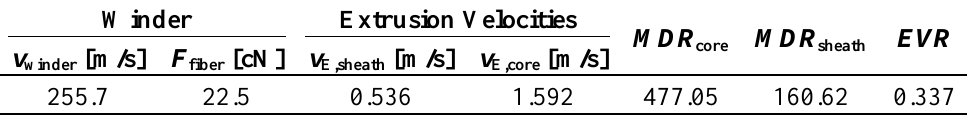
Table 2. Drawing parameters for bicomponent melt spinning.